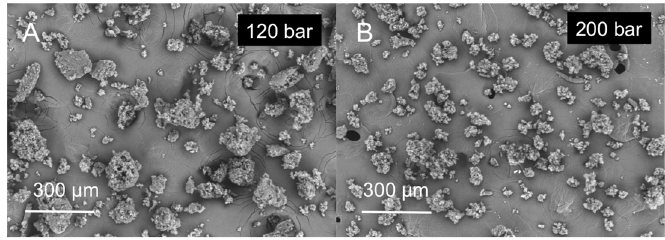
Figure 4. Effect of pressure in the PGSS ® processing of GMS particles: ( A ) GMS-1-67-120 and ( B ) GMS-1-67-200 particles.